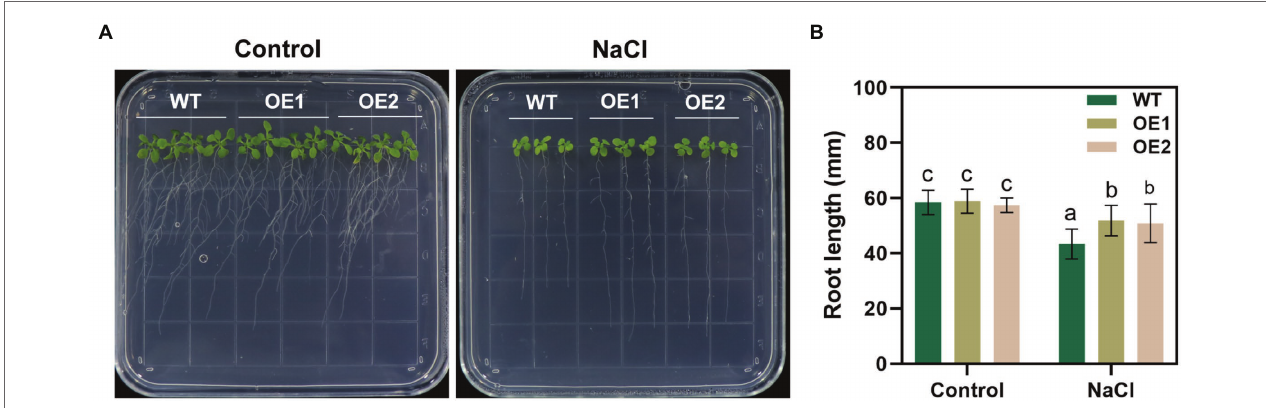
FIGURE 3 | Effect of NaCl on root length in the GlNPC3 -overexpressing plants. (A) Phenotypes of the wild-type (WT) and transgenic Arabidopsis thaliana during salt stress. The seeds were grown on agar plates supplemented with 0 mM (control) or 75 mM NaCl for 14 days. Representative photographs of the plants are shown. (B) Root length of 14-day-old seedlings. Data represent mean ± SD, n = 48. Different letters above each bar indicate a significant difference ( p < 0.05, Duncan’s multiple range test).